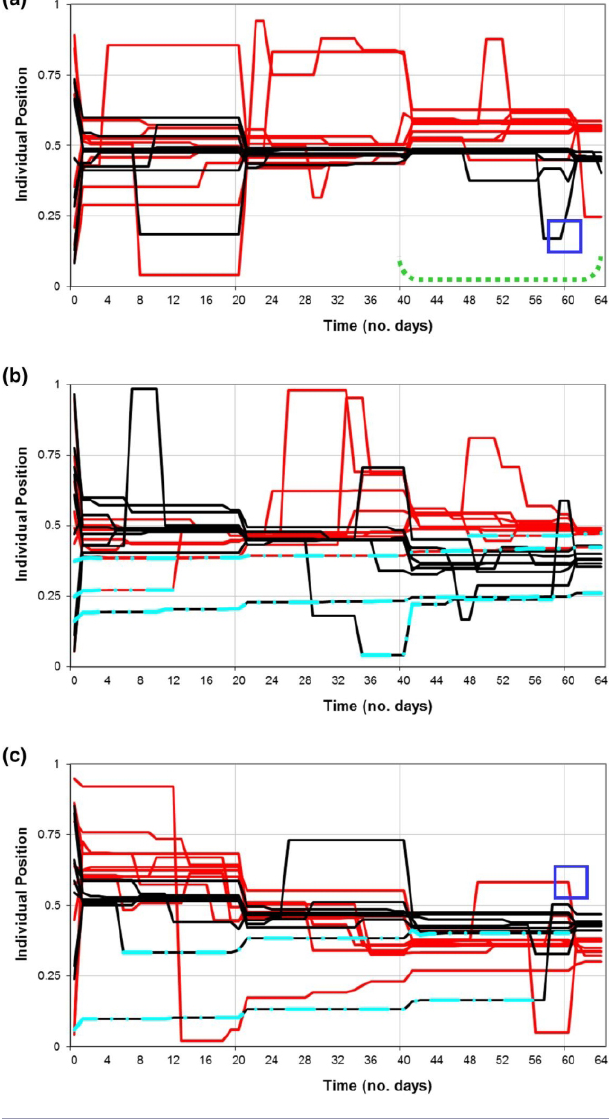
Fig. 10 . Evolution of individual positions in two groups across cost of dissent and entrenchment scenarios with a 10% mutation rate: (a) Scenario C2, (b) Scenario C3, and (c) Scenario C4. Dotted green line indicates period of the run during which cost of dissent occurs. Blue squares show examples of agents affected by cost of dissent. Turquoise dotted-line overlay indicates duration of agent